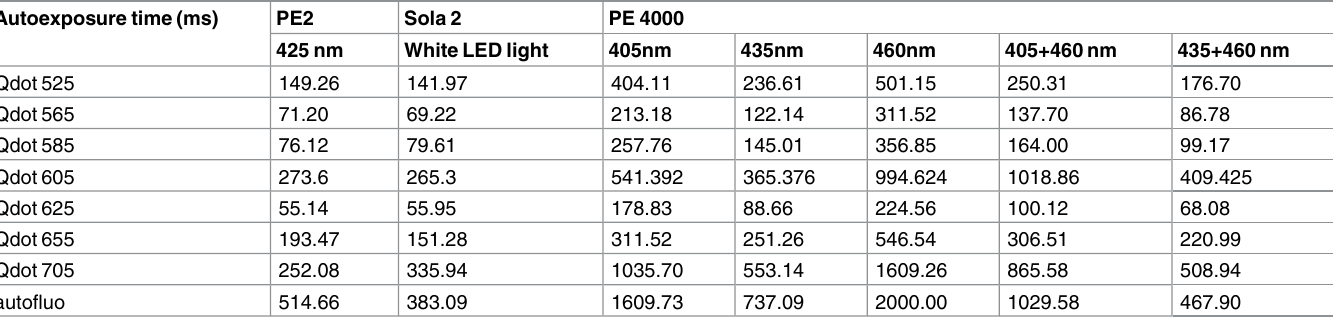
Table 4. Autoexposure timesto achieve 70% of the dynamic range. Autoexposure time (ms)